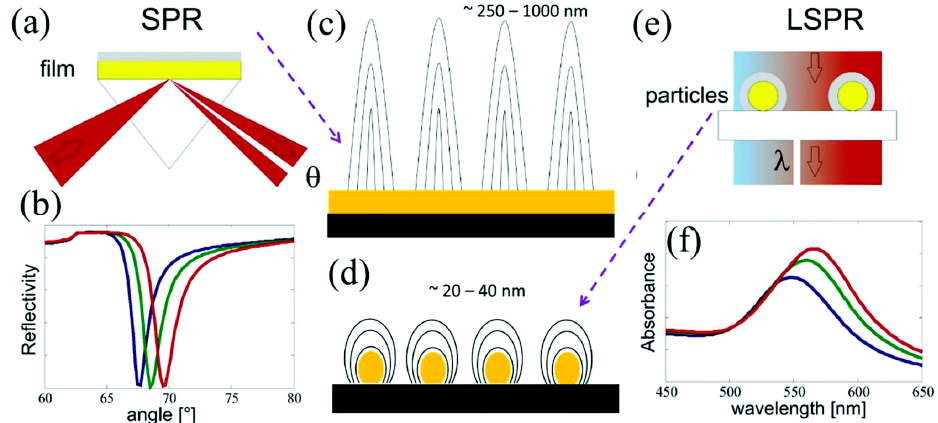
Figure 2. Scheme of SPR ( a – c ) and LSPR ( d – f ) mechanisms. λ is the wavelength [nm] and θ the angle of reflection [°]. (Reproduced with permission from [27], open access Creative Common CC licensed 3.0, Royal Chemical Society—RSC).